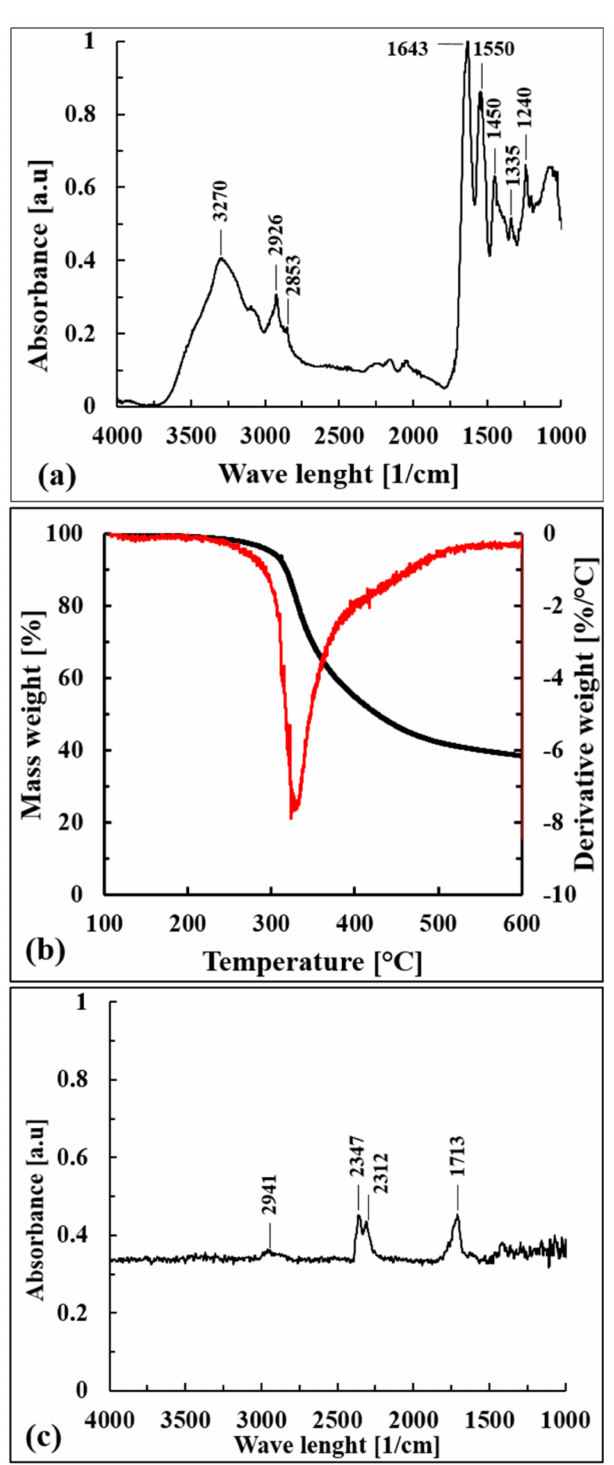
Figure 2. ( a ) ATR spectrum of WB fibers, ( b ) TGA and DTA curves of dried WB fibers, and ( c ) FT-IR spectrum of degradative products released by WB fibers at T peak (328.6 ◦